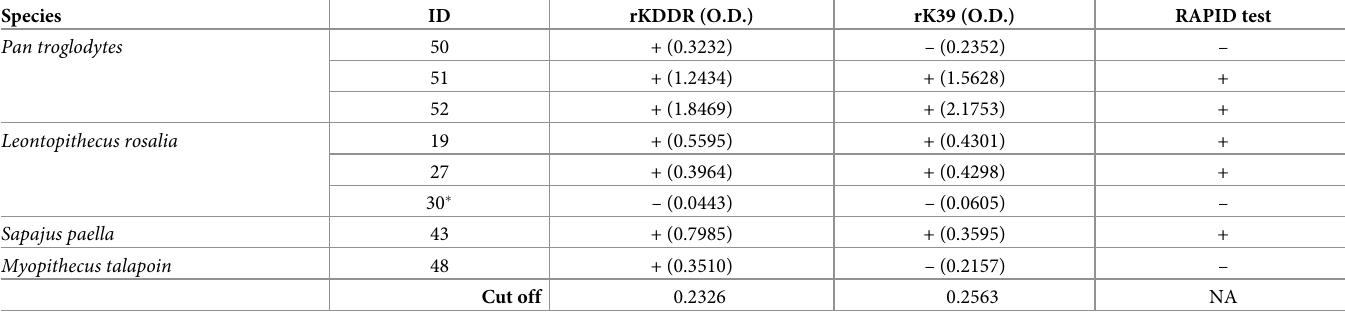
Table 2. Serologically positive non-human primates for leishmaniasis with three different serological assays. Legend: ID: individual identification of each animal. NA: not